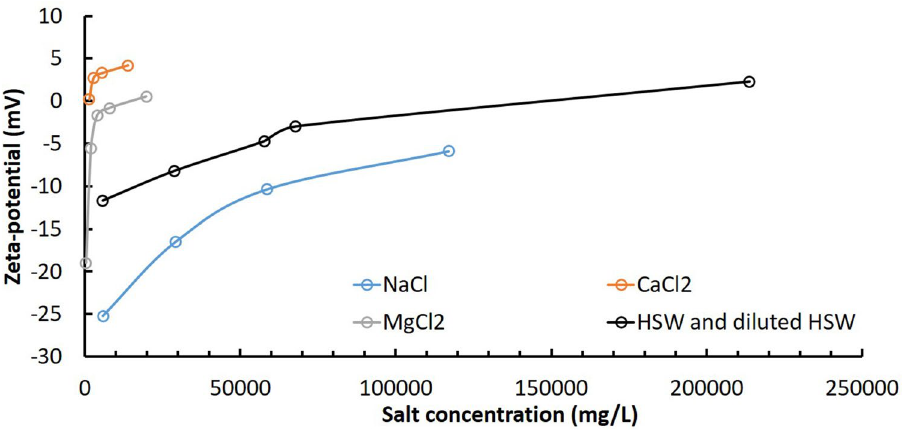
Figure 4. Salt effects on the zeta-potential of calcite